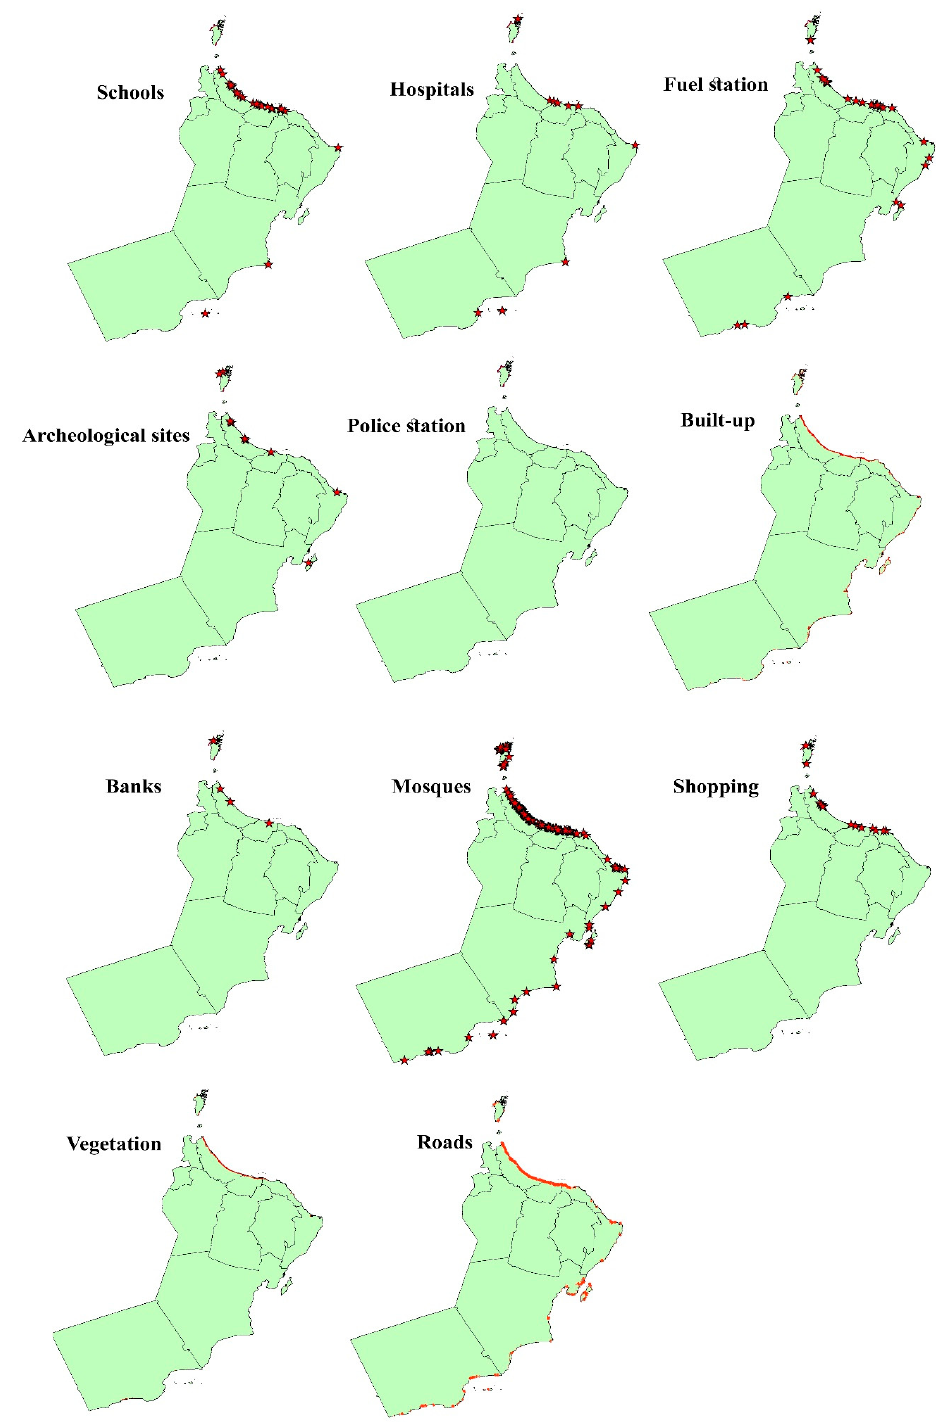
Figure 6. The distribution of the impacted infrastructure features by an 8 m run-up height tsunami.